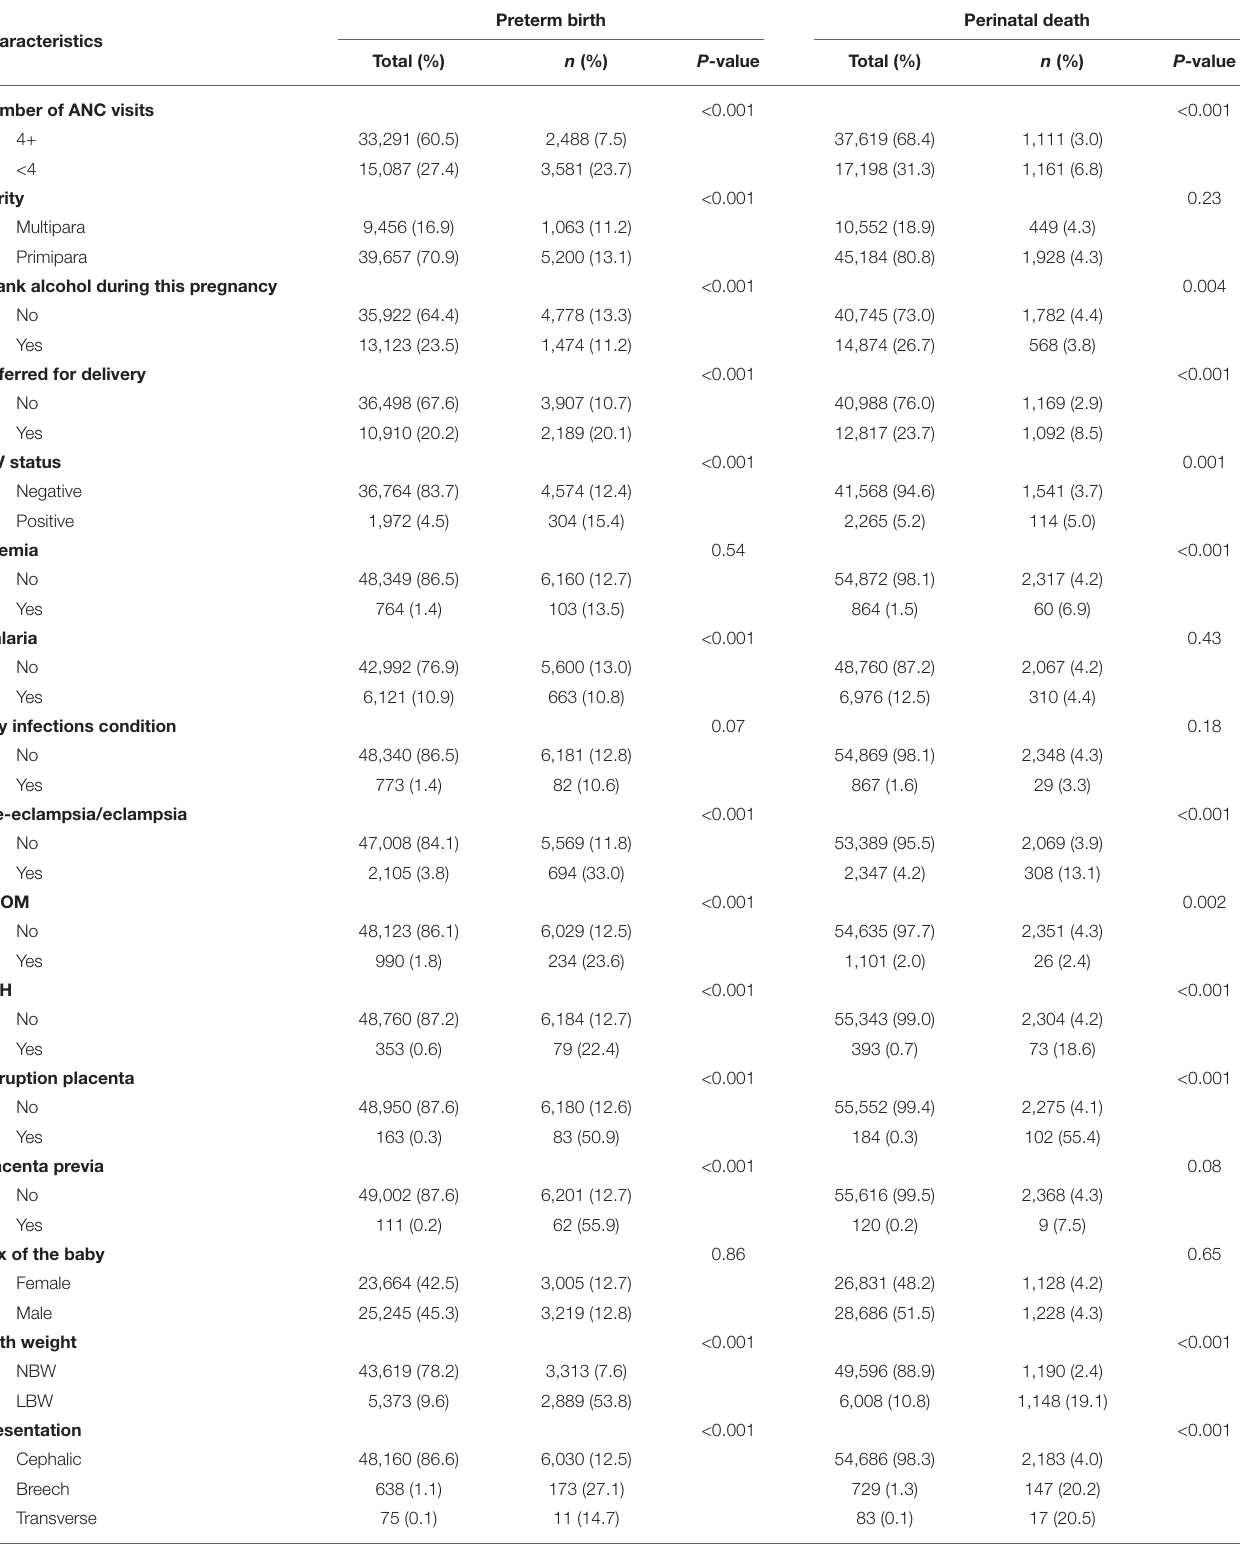
TABLE 2 | Distribution of preterm birth and perinatal death by maternal conditions and complications during pregnancy and delivery ( N = 55,907).